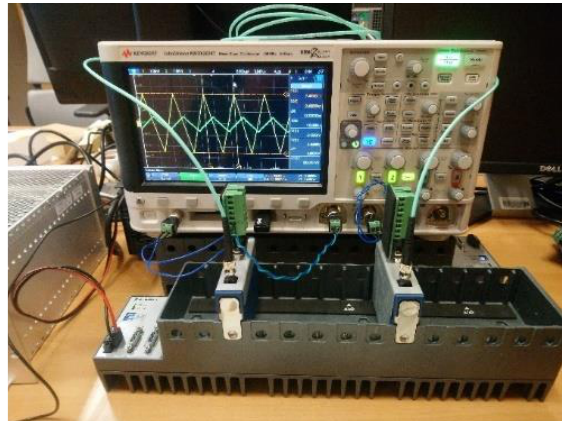
Fig. 6. Hotlink modules